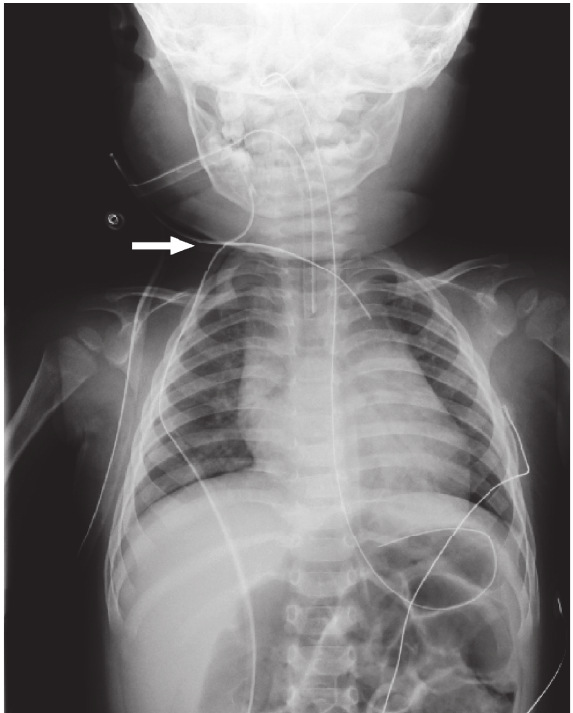
Figure 2: Chest radiograph after percutaneous drainage tubes were placed. The white arrow shows the insertion site. One was placed in the right neck, and the other was placed in the anterior